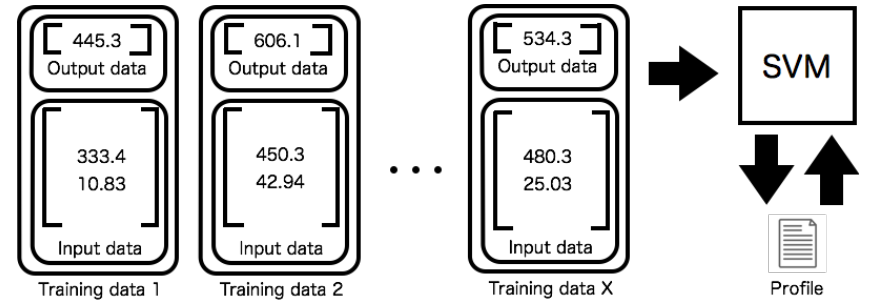
Figure 4. Training process of a profile between two sensors for spatiotemporal interpolation of missing data. The training data consisting of tuple data set are input to an SVM. The SVM learns desired outputs (interpolated value) from the training data set. This profile is used for interpolation. On the other hand, the profile shown in Figure 3 is used for evaluating relations between two